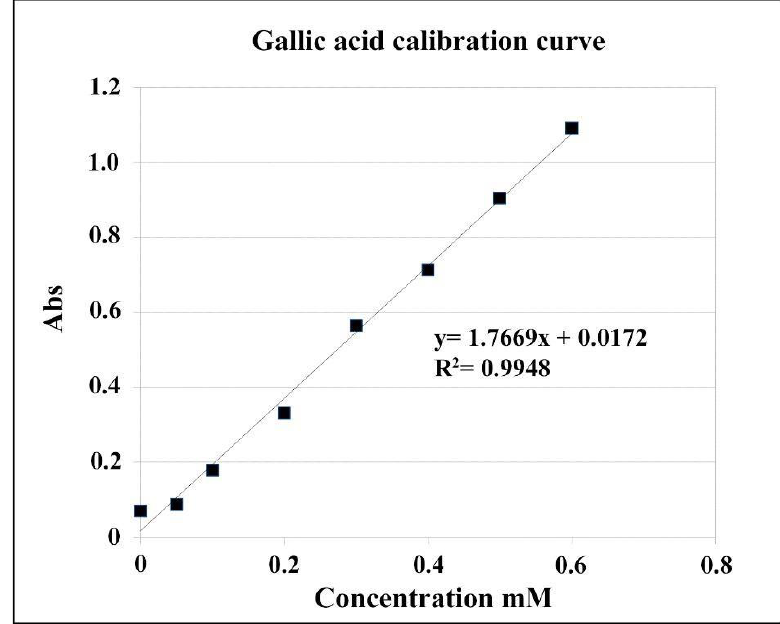
Figure 1. Gallic acid equivalent calibration curve. Table 2. Gallic acid data with absorption spectrophotometric values ( n = 3). Gallic Acid